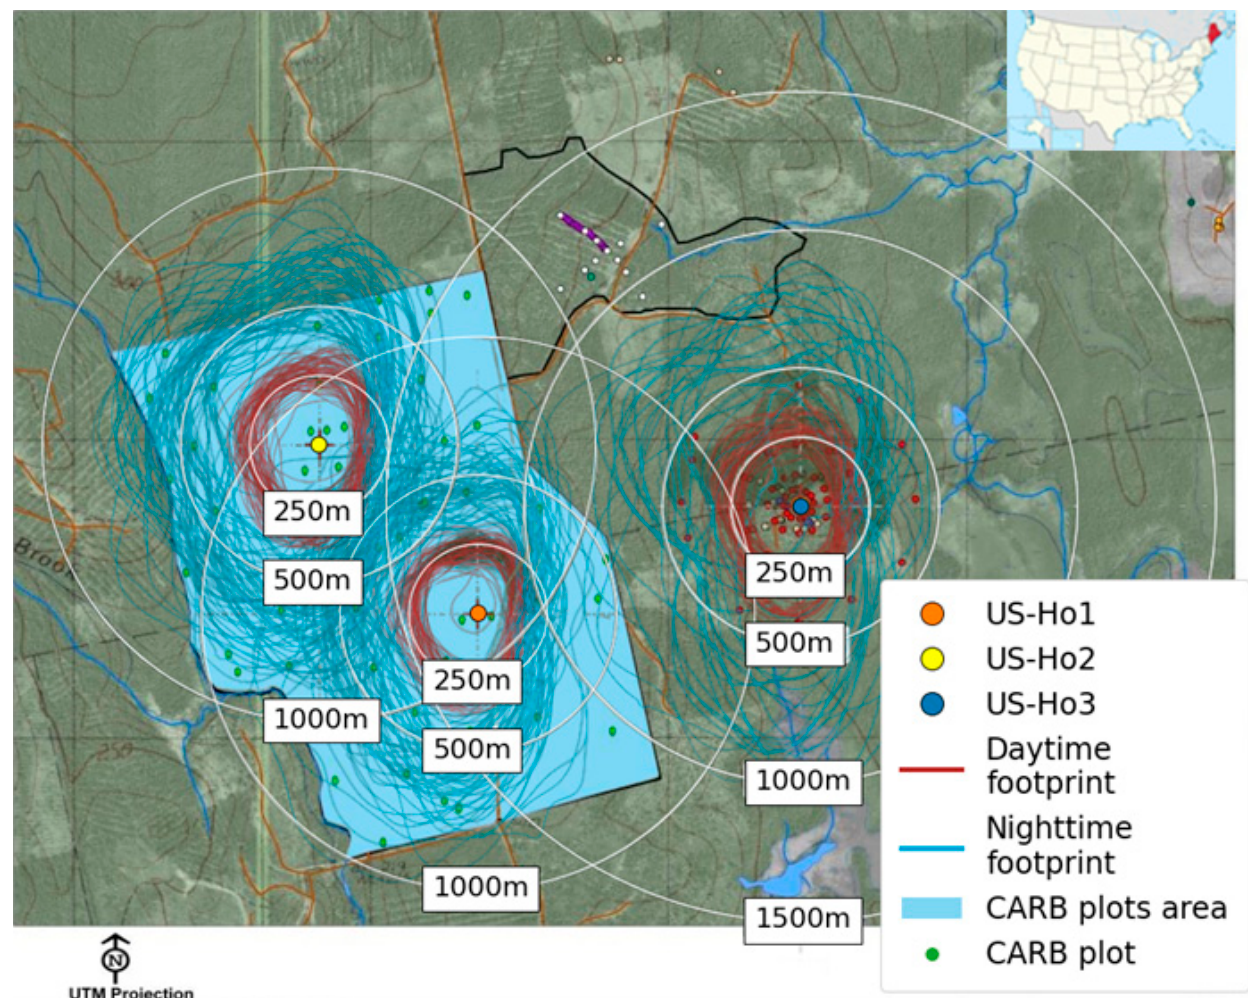
Figure 1. Map of the Howland research area. Tower locations (yellow circles; the towers are: Ho2 west, Ho1 center, and Ho3 east), daytime and nighttime monthly climatology footprints (red and light-blue lines, respectively), California Air Resources Board CARB) measurements area (light blue area), and CARB individual plots (filled green circles) are represented. As a reference, white circles indicate the areas within 250, 500, 1000, and 1500 m around each tower. Small white, purple, red, and orange dots belong to the original base map and correspond to measurements done at the Howland site, but they are not relevant to this study. The map was redrawn from https://umaine.edu/howlandforest/about/ (accessed 25 March 2021) and [17]; monthly climatology data are from [42]. Note: CO 2 fluxes used in this study were measured above the canopy at a 29 m tower with the eddy covariance technique since 1996 (US-Ho1; “the main tower”), from 1999 to 2004 (US-Ho2; “west tower”), and from 2004 to 2007 (US-Ho3). US-Ho1 includes CH 4 measurements from 2012 to 2018, and it is approximately 775 m apart 116 from US-Ho2.US map insert acknowledgment: https://commons.wikimedia.org/wiki/File:Maine_in_United_States.svg (accessed 2 March 2021).